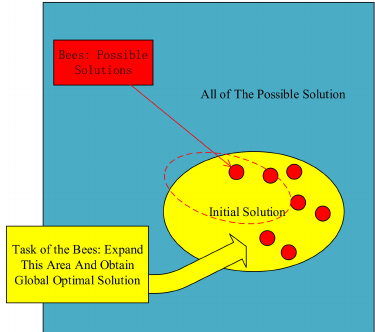
Figure 6. Mechanism of artificial bee colony